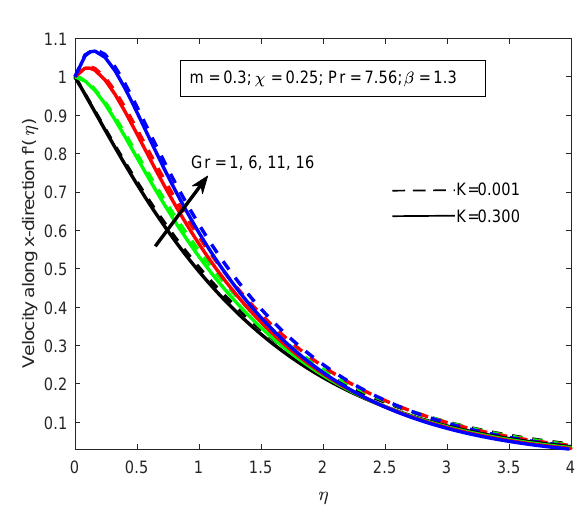
Figure 20: Variation of velocity profile in the x − direction with Grashof